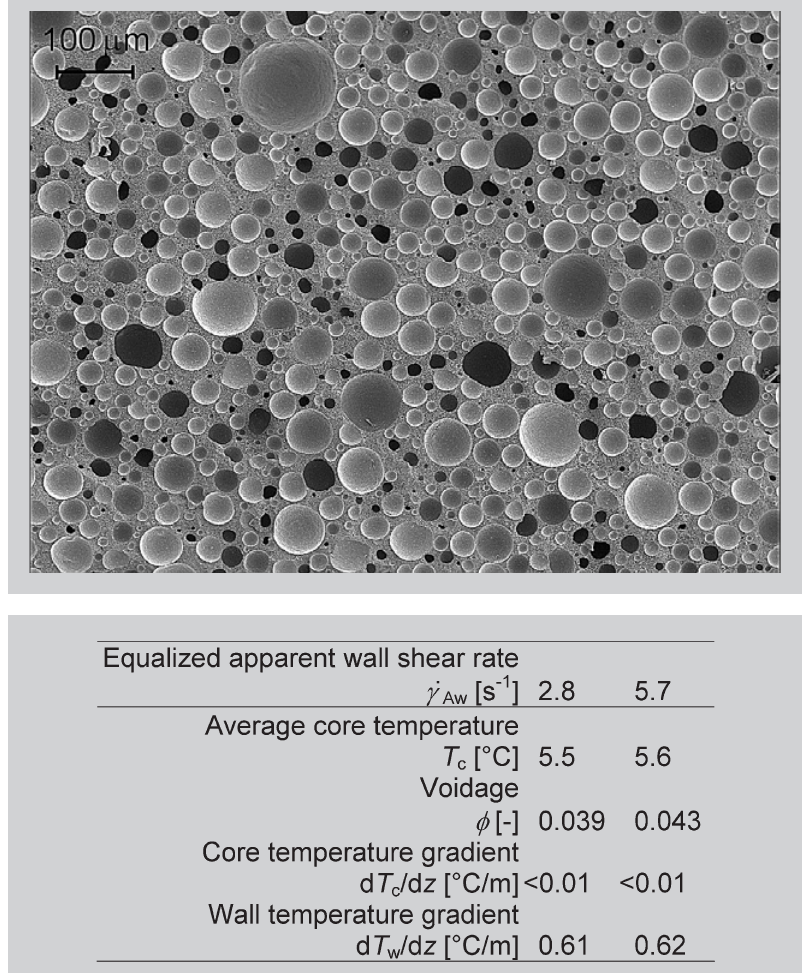
Figure 6: LT-SEM of model ice cream foam illustrating size and number of bubbles. Table 2: Ice cream temperature gra-